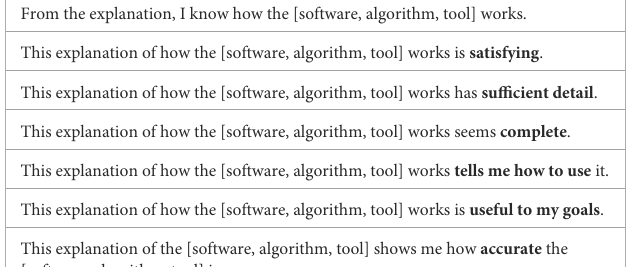
TABLE 3 The explanation satisfaction